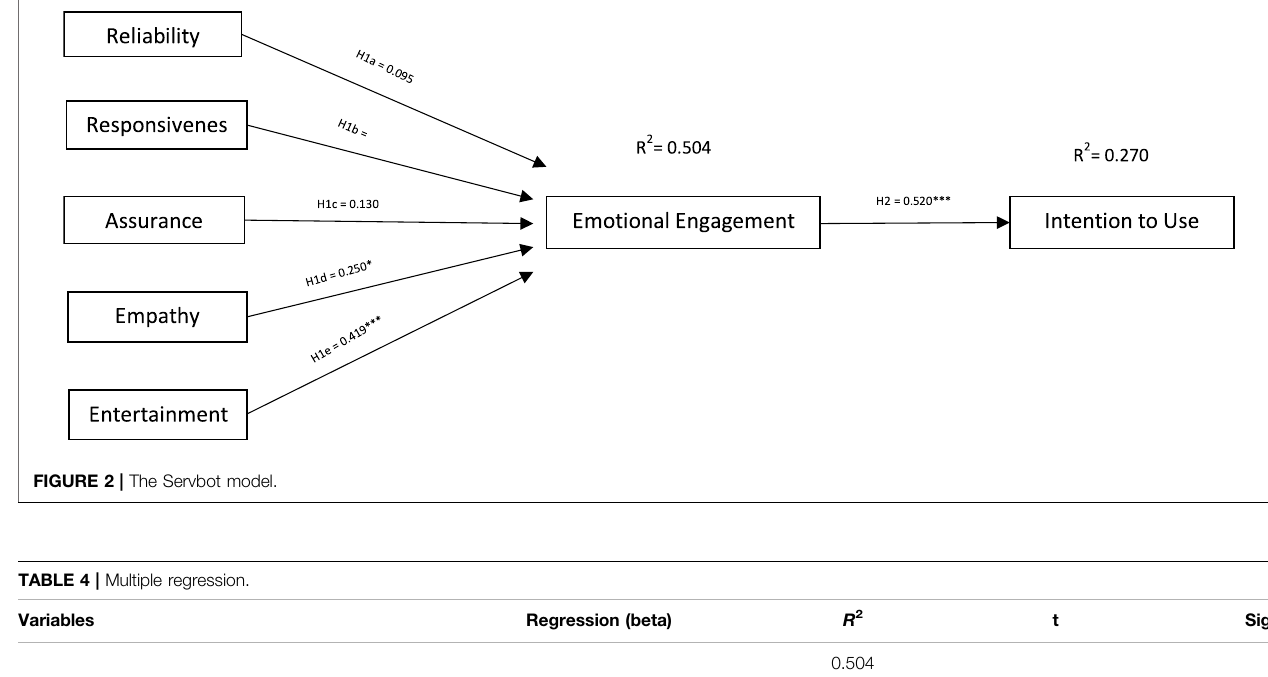
TABLE 4 | Multiple